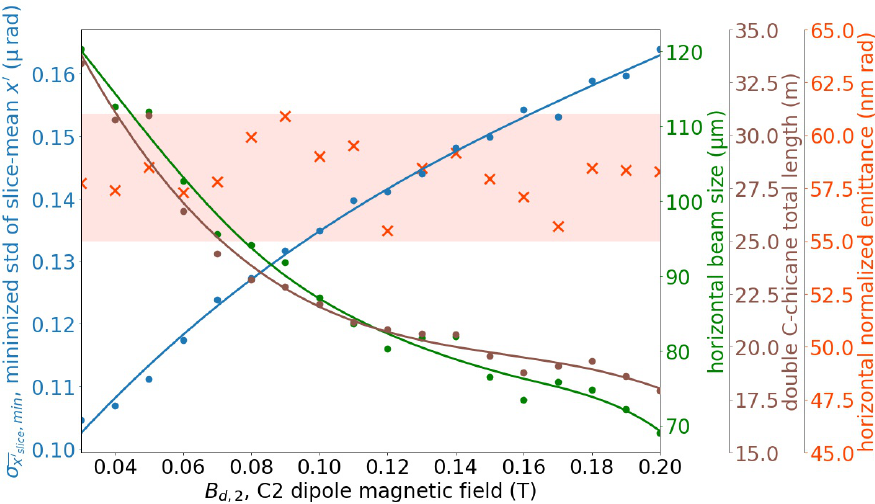
Figure 7. Summary plot of the entire 3D parameter scan for the optimization of BC1 using a double C-chicane scheme. The minimum value of the current-weighted standard deviation of the slice- average horizontal kick of all 1000 slices of the beam σ (blue), the horizontal beam size (green) x (cid:48) slice , min as well as the projected horizontal normalized emittance (red) at the double C-chicane BC1 exit, and the total length of the double C-chicane BC1 lattice (brown) were calculated for each value of the C-2 dipole magnetic field B d ,2 used in the parameter scan, and the results were